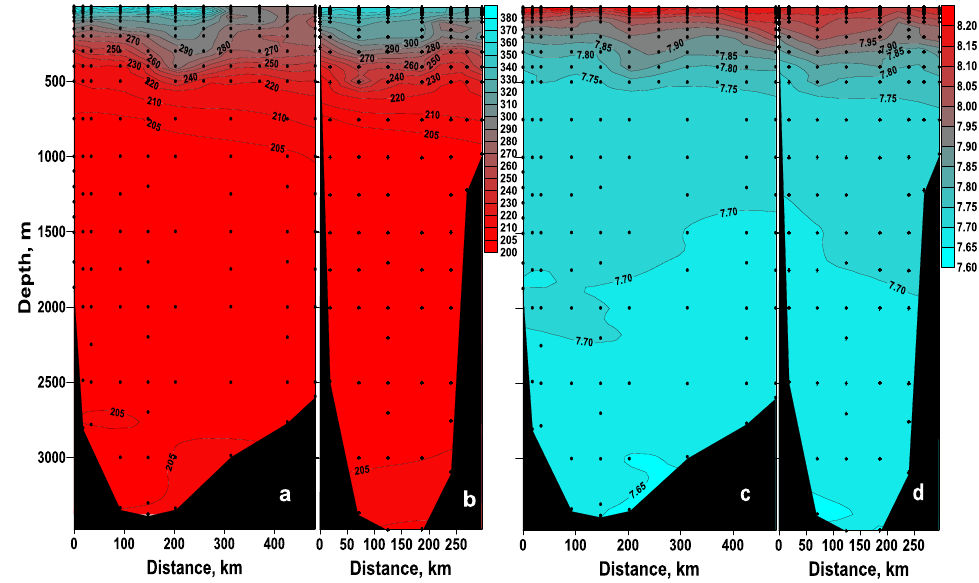
Figure 3. Meridional sections of dissolved oxygen concentrations ( a , b ) and pH in situ ( c , d ) along 132°20′ E ( a , c ) and 134°00′ E ( b , d ), April 2014.